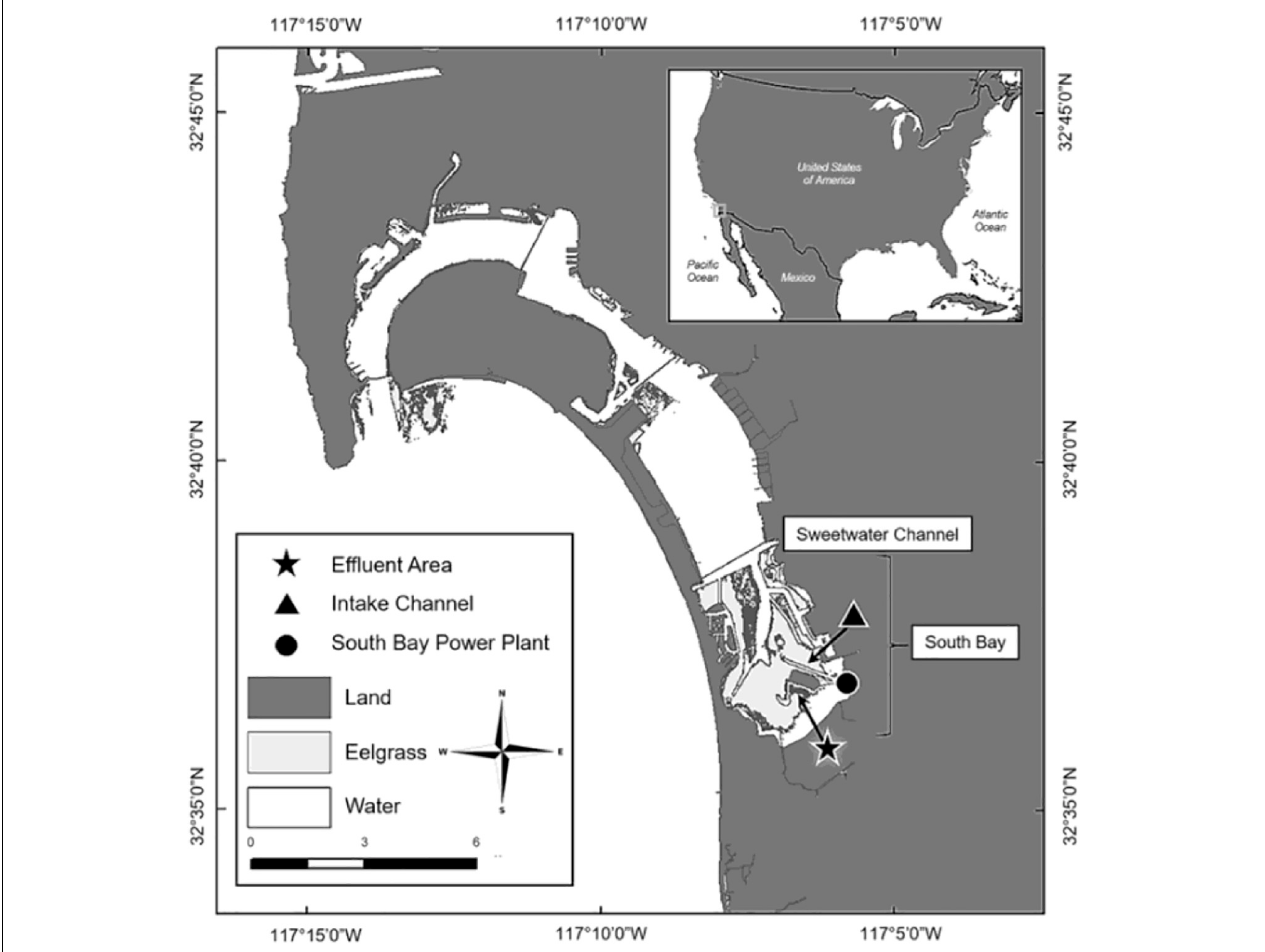
FIGURE 1 | San Diego Bay is located in Southern California, close to the US-Mexico Border ( inset ). Chelonia mydas primarily inhabit the Intake Channel located south of the Sweetwater Channel, in an area known as South Bay (Madrak et al.,